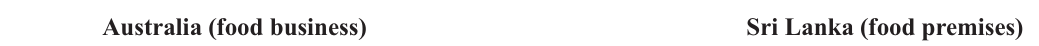
Table 1: Definition of food business / premises